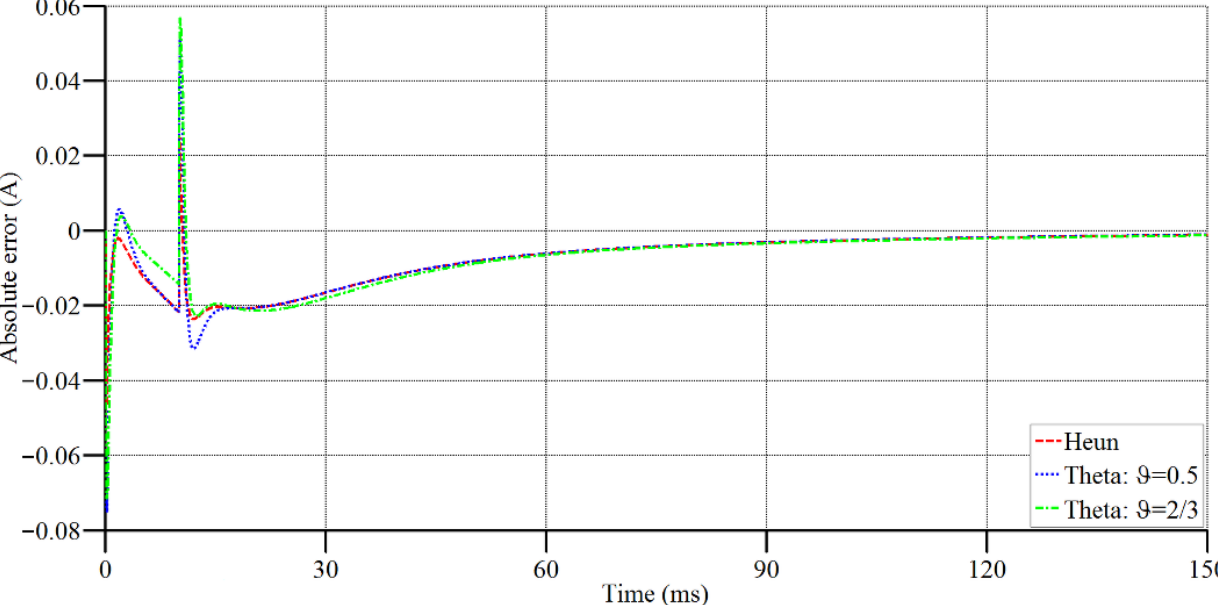
Figure 6. Absolute errors of the current in the first branch.